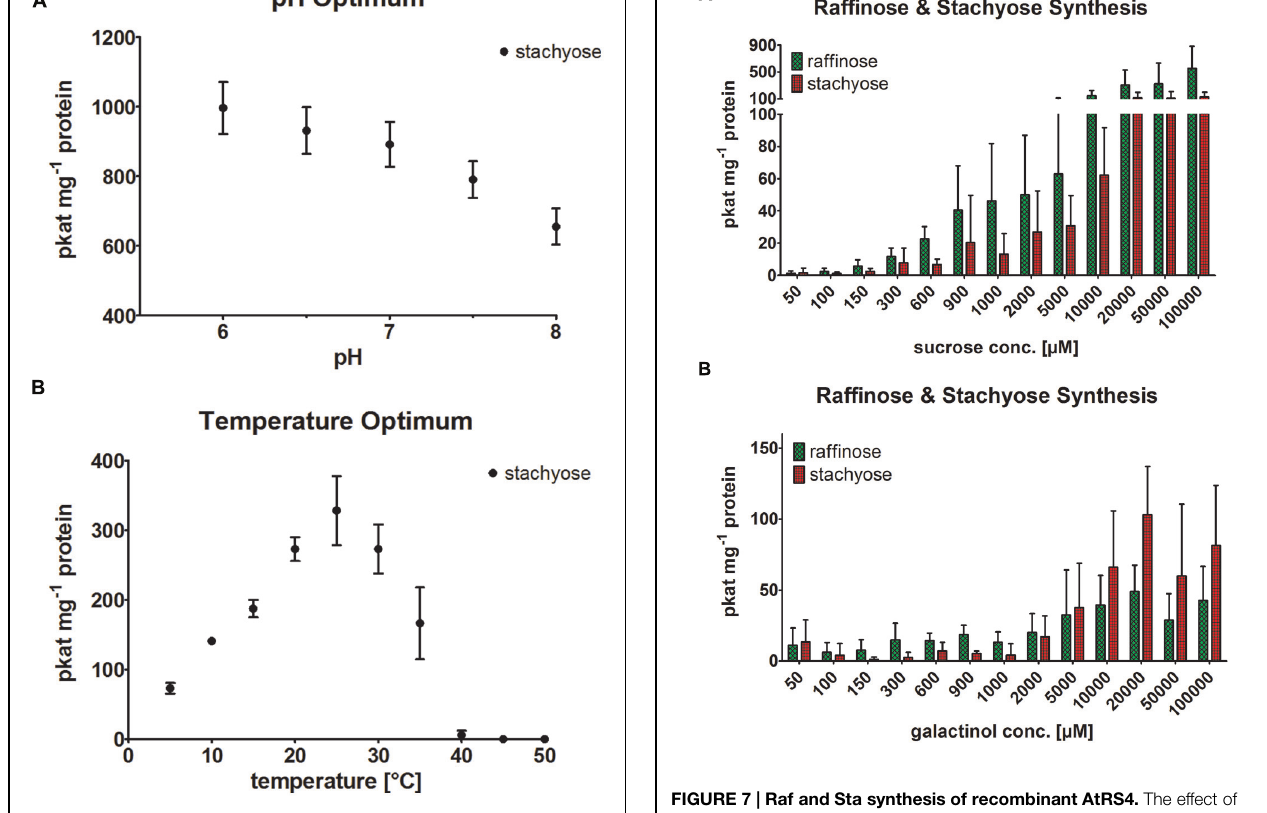
FIGURE 5 | pH and temperature optimum. (A) The effect of different pH values on StaS enzyme activity of recombinant AtRS4 and (B) the dependence of StaS enzyme activity of recombinant AtRS4 on reaction temperature were measured with HPAEC-PAD enzyme assays. Sta concentration was determined using HPAEC-PAD enzyme assay. Values are averages of three independently performed assays ( ± SD).